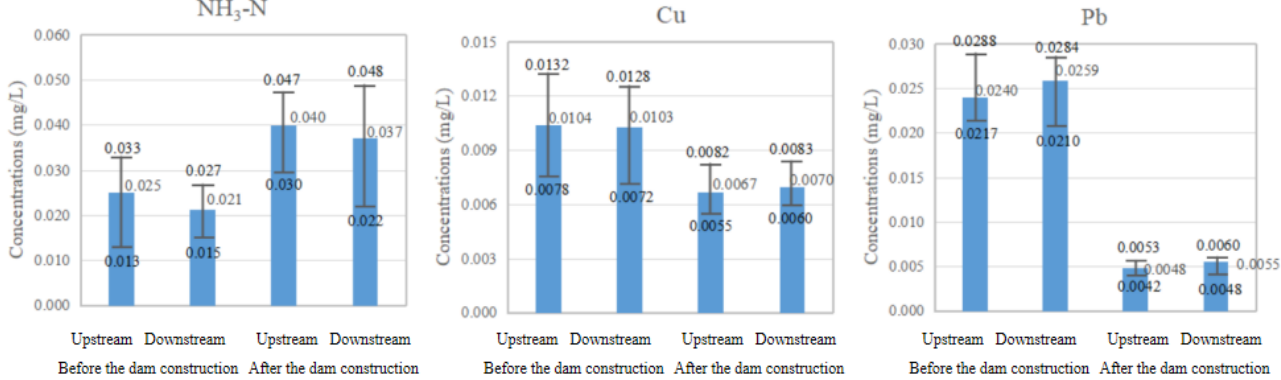
Figure 5. Concentrations of pollutants. Upstream Downstream Before the dam construction Aefore the dam construction.